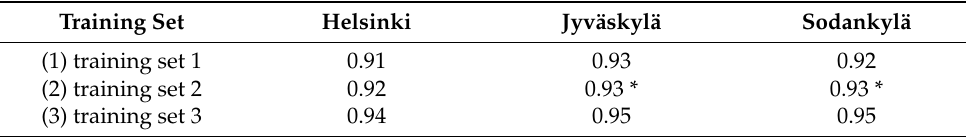
Table 5. R 2 in the test set for different geographical locations.